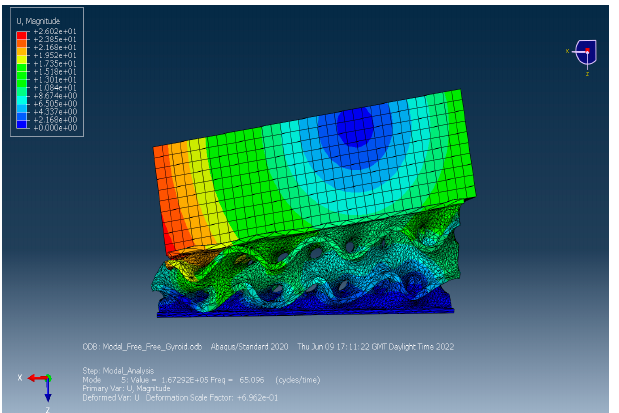
Figure 18. FEA simulation of the proposed 3D-printed gyroid bridge bearing model subjected to free vibration as considered in SDOF.